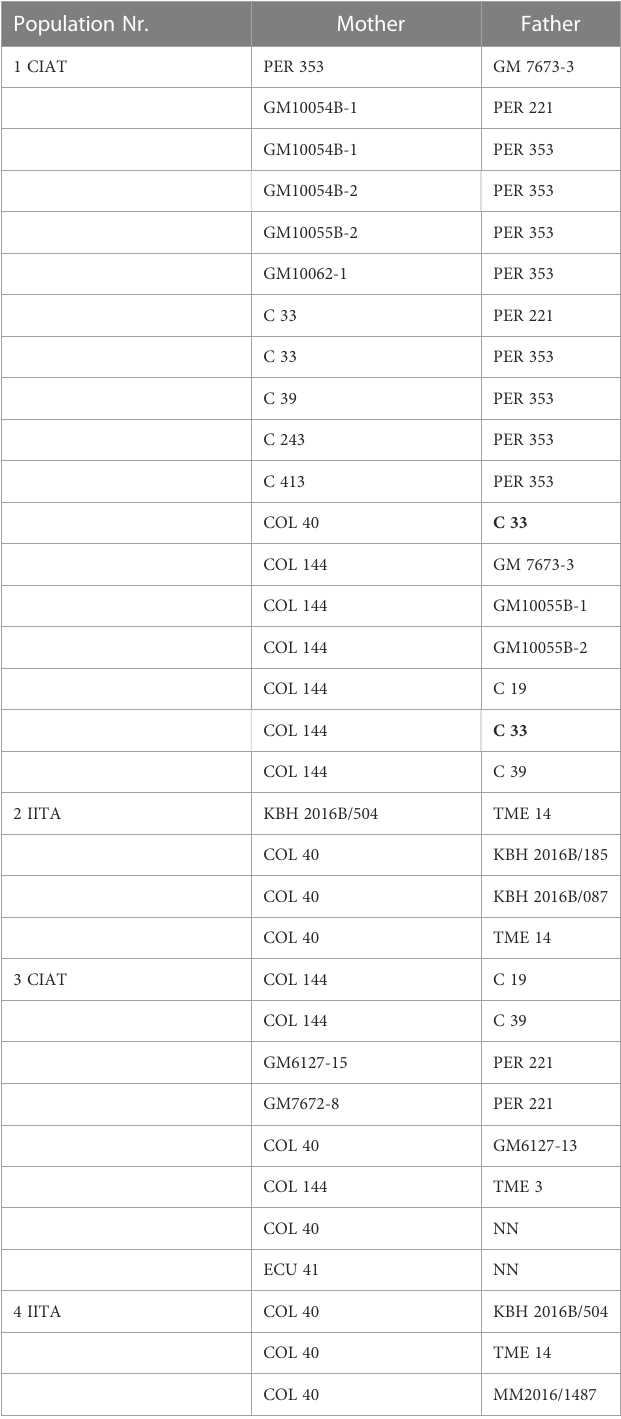
TABLE 3 Cassava crossing populations generated at CIAT and IITA with U/ CBSV-resistant parents. Population